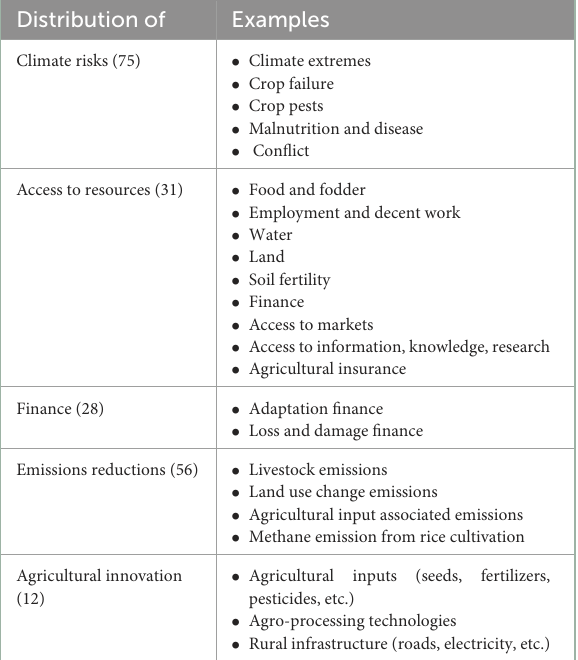
TABLE 4 References to unequal distribution within Koronivia workshops and submissions organized on the basis of distributional justice sub codes identified within Table